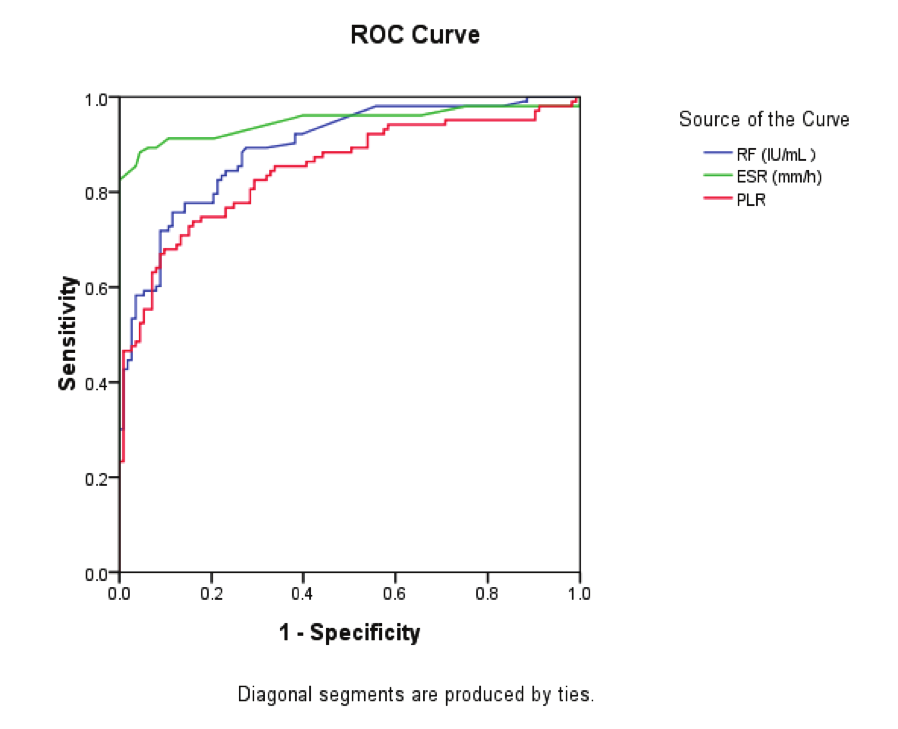
Figure 1: Receiver operating characteristic (ROC) curves of ESR, RF, and PLR levels for patients with